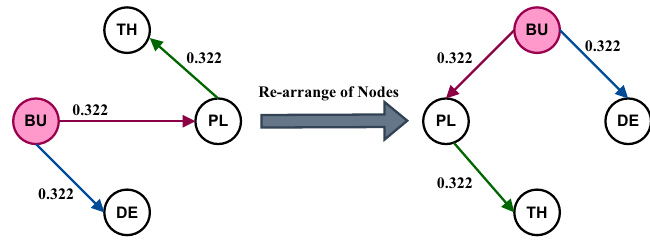
Fig. 6 Assignment of Root nodes (a) Choose Th as root node and its LL − 5.033 (c) Choose PL as root node and its LL and its LL = 7.359